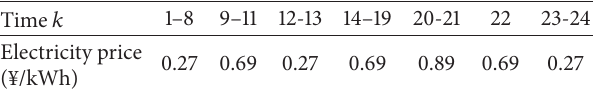
Table 3: The time-of-use electricity price 𝑃 𝑒 ( 𝑘 ). Time